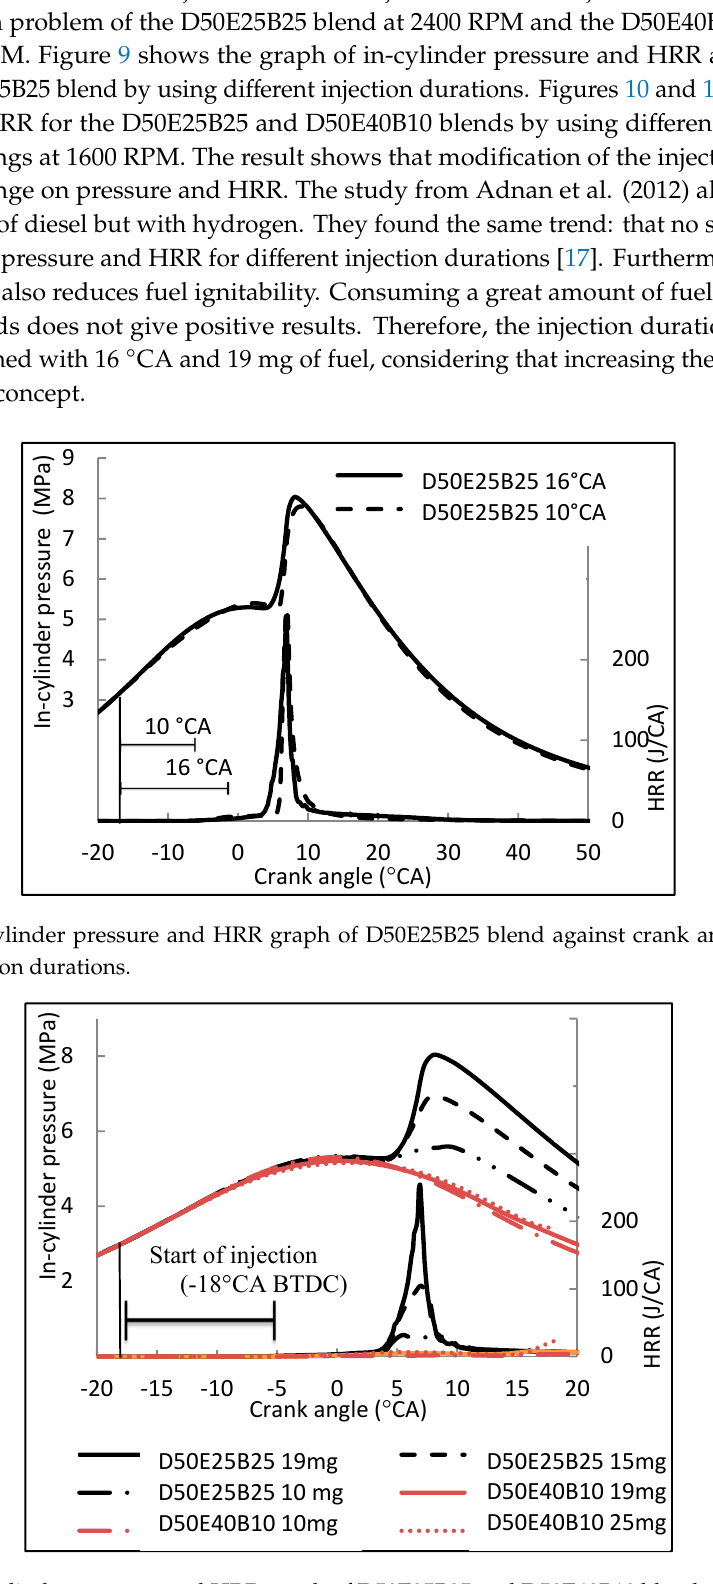
Figure 11. In-cylinder pressure and HRR graph of D50E25B25 and D50E40B10 blends against a crank angle by using different injection times. However, advancing the injection timing at the early time before the top dead center (TDC) may lead to another problem. Although advancing the injection timing improves the fuel ignitability, injecting the fuel too early can lead to the incomplete fuel combustion. Thus, the situation will increase the hydrocarbon, carbon monoxide, and soot emission. As observed in the emission graphs in Figure 12, emissions of CO, HC, and C 2 are high with the advancement of the injection timing for the D50E25B25 blend. A few studies found that advancing the injection timing reduced the carbon emissions, while considering that the ignition started early. However, the transition of liquid fuel turning into gas is very slow, especially at high engine speeds, and leads to incomplete combustion due to the ethanol presence [19]. Figure 12 shows the emission graphs for D50E40B10 blends with two di ff erent injection timings. Injection at − 18 °CA BTDC does not have any ignition due to the high ethanol presence. Advancing the injection timing with − 25 °CA BTDC was able to ignite the fuel, as shown in Figure 8. As illustrated in the graph, CO 2 , CO, and NO x emissions still occur, because the reaction between the hydrocarbon and air occurs in the combustion chamber. However, the reaction itself is insufficiently high to release additional energy for igniting the fuel, which results in a low temperature. Therefore, the ignition hardly occurs. The graph shows that the CO, CO 2 , C 2 , and NO x